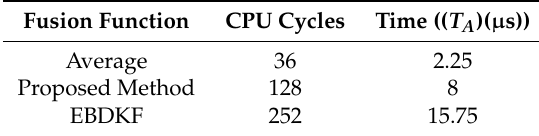
Table 2. CPU Overhead of Different Information Fusion Functions for chain-based